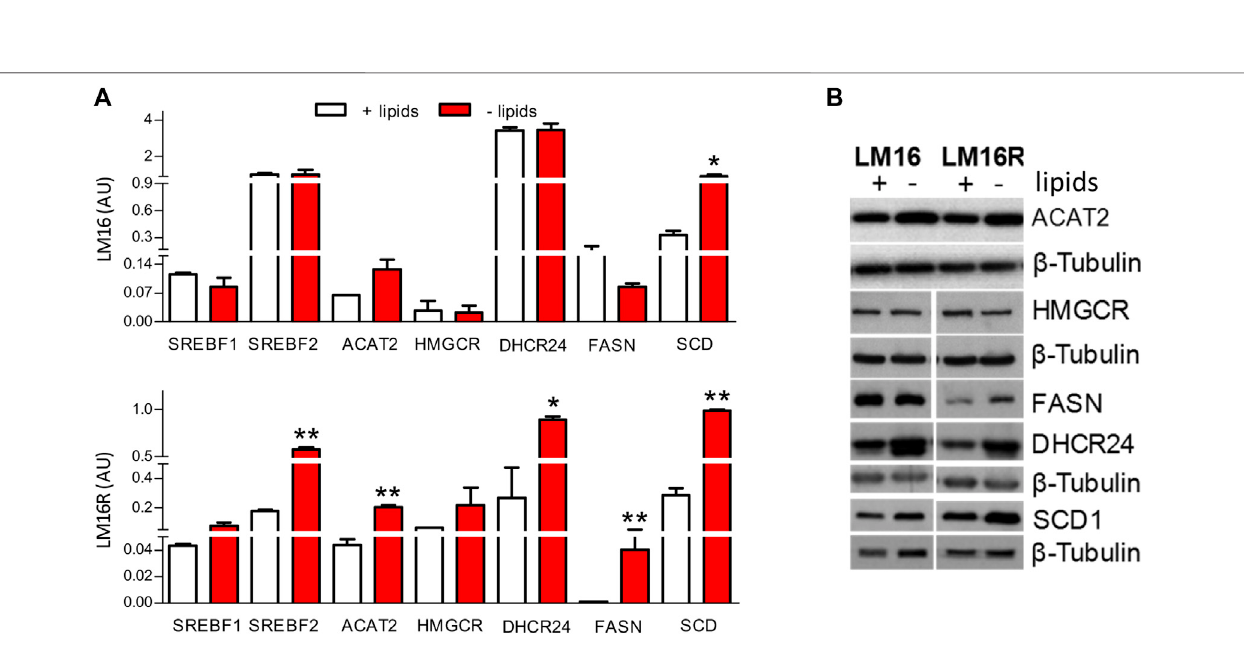
Frontiers in Cell and Developmental Biology |